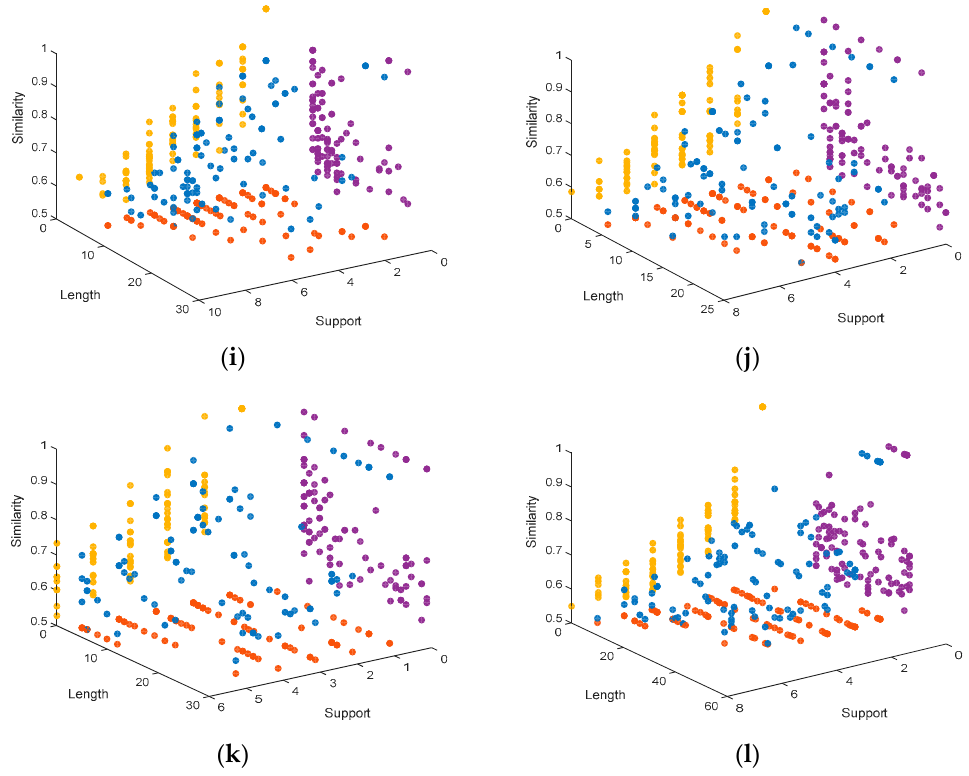
Figure 1. Representation of the Pareto fronts obtained by MHABBO: ( a ) the distribution of solutions on the DM01g dataset; ( b ) the distribution of solutions on DM04g; ( c ) the distribution of solutions on DM05g; ( d ) the distribution of solutions on HM03r; ( e ) the distribution of solutions on HM04r; ( f ) the distribution of solutions on HM16g; ( g ) the distribution of solutions on MUS02r; ( h ) the distribution of solutions on MUS07g; ( i ) the distribution of solutions on MUS11m; ( j ) the distribution of solutions on YST03m; ( k ) the distribution of solutions on YST04r; ( l ) the distribution of solutions on YST08r.